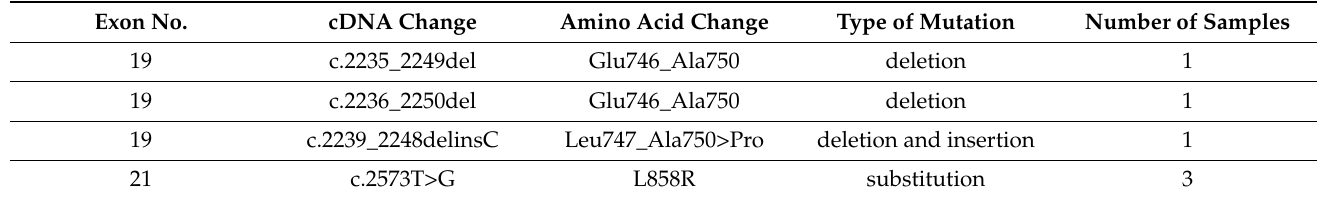
Table 5. EGFR mutations present in brain metastasis